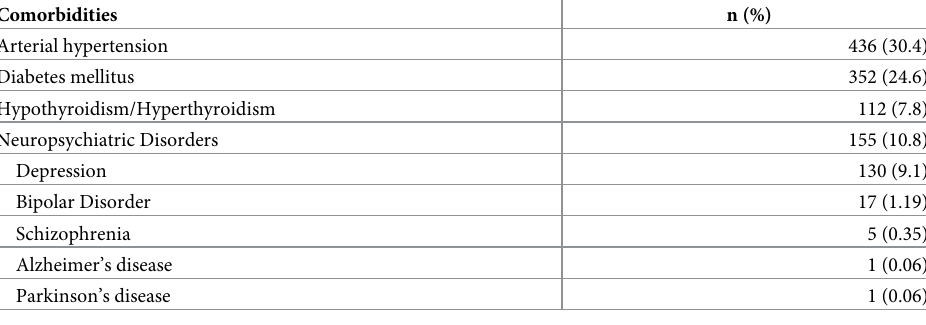
Table 1. General description of the main